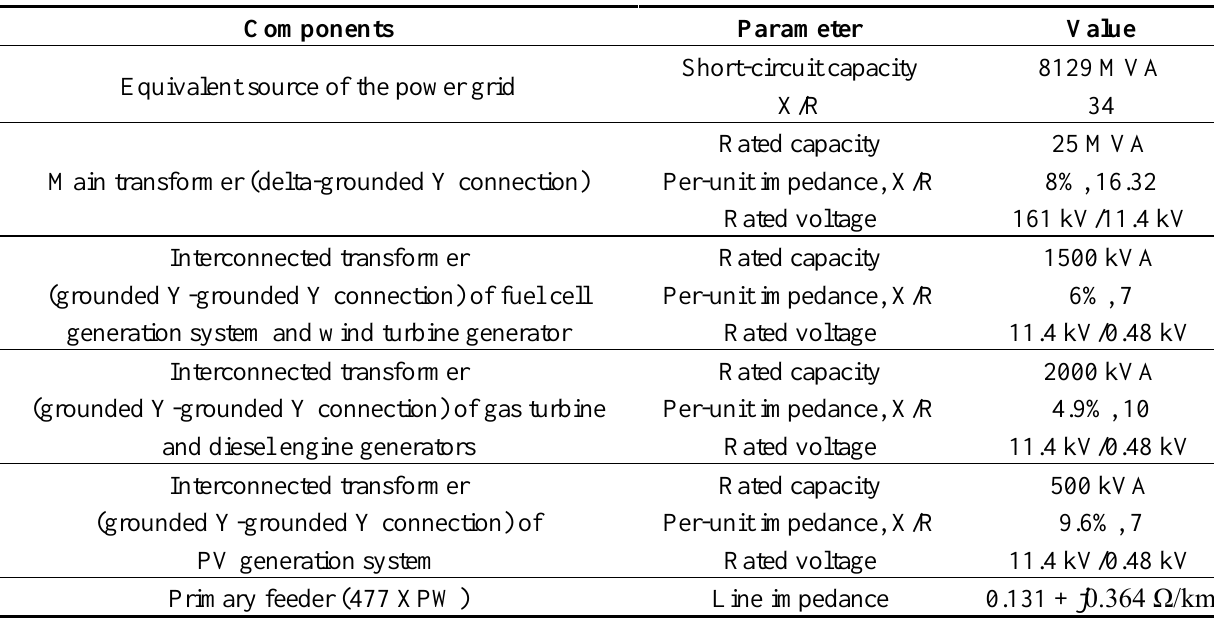
Table 1. Parameters of the circuit components. PV: photovoltaic; and XPW: cross-linked polyethylene